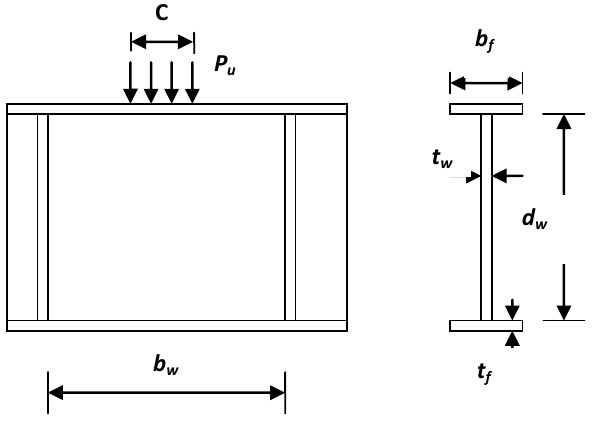
Fig. 2. Patch loading and girder